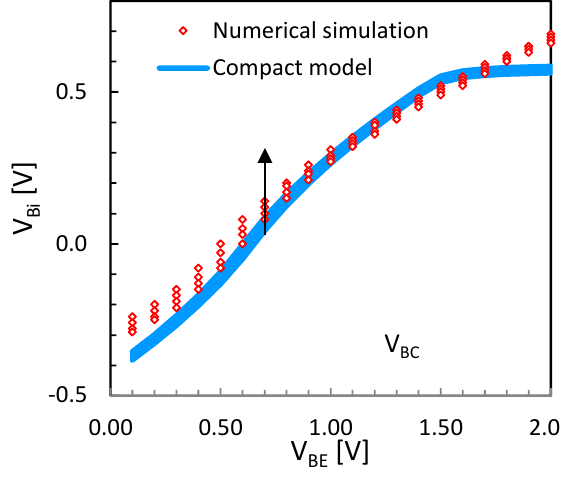
Figure 4. Graphene Fermi potential versus V BE curves for different V CB (2, 3, 4, 5 V), numerical simulation and compact model simulation.